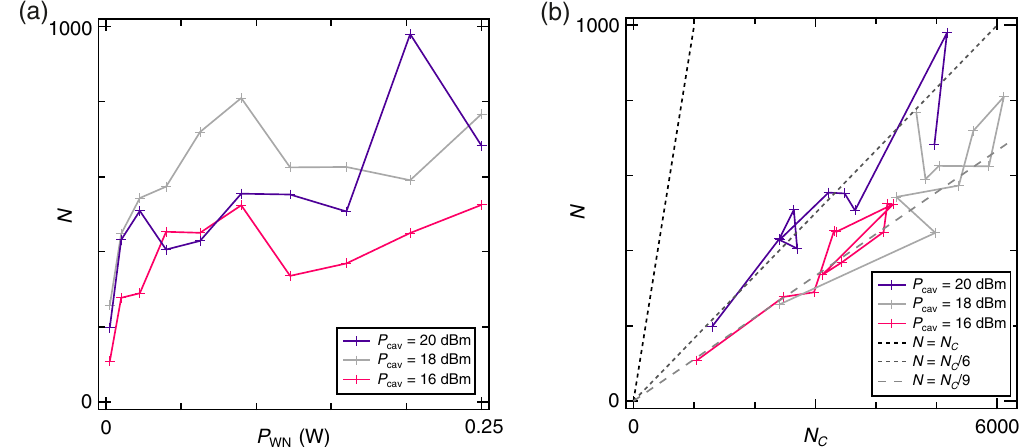
FIG. 8. (a) Accuracy N of the clock versus the white-noise power P for cavity drive powers in the range 16 – 20 dBm. (b) Accuracy WN N of the clock versus N for cavity drive powers in the range 16 – 20 dBm.The black dotted line is a guide for the eye to show the C expected gradient should the extracted accuracy and the theoretical accuracy predicted from the entropy production be equal. The dark = 6 and the light gray line shows the approximate gradient gray dotted line shows the approximate gradient of the 20 dBm data of N ¼ N C = 9 of the 16 and 18 dBm data of N ¼ N C